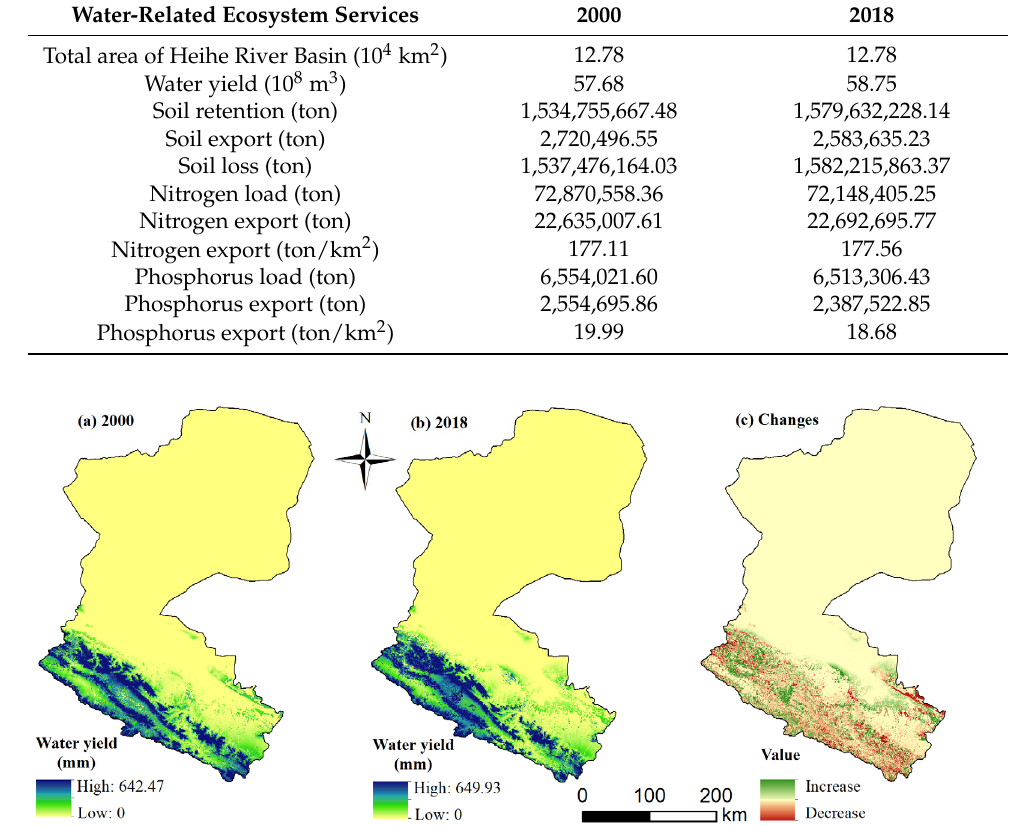
Figure 5. Spatial distribution and changes in water yield from 2000 to 2018. ( a ): water yield in 2000; ( b ): water yield in 2018; ( c ): changes from 2000 to 2018).